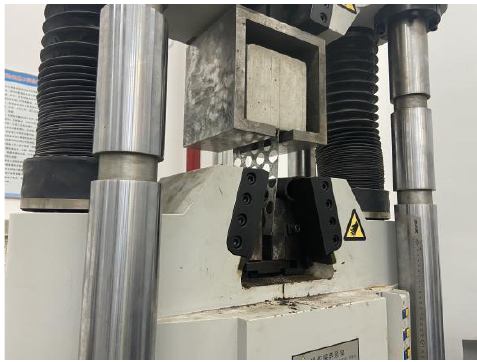
Figure 6. Pull-out test on perforated steel plate reinforced concrete.